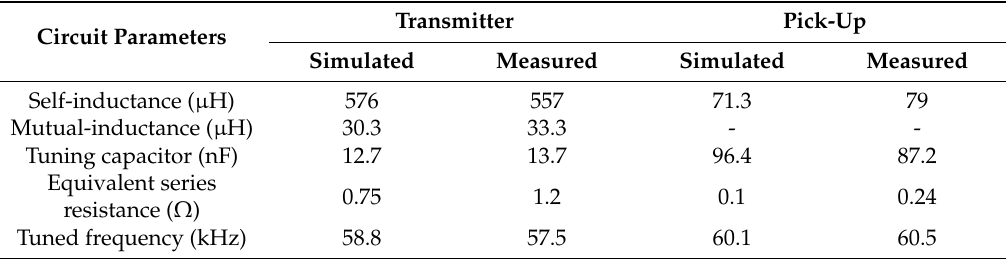
Table 3. Simulated and measured circuit parameters of the transmitter and the pick-up.